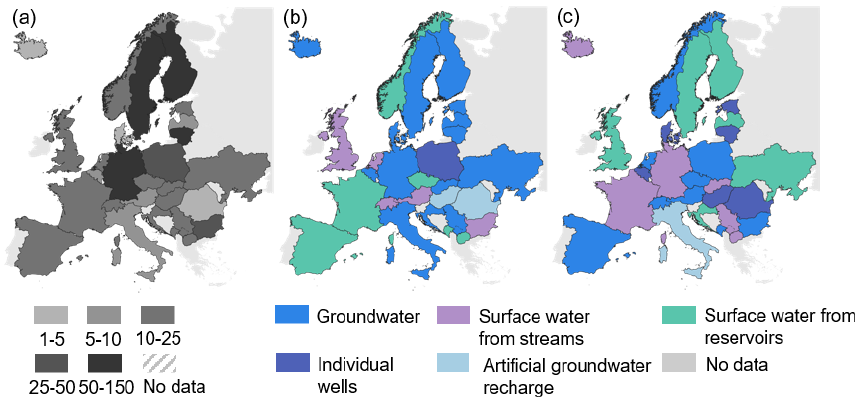
Figure 2. Water usage across Europe: (a) number of survey participants by country, (b) most important water resource by country, and (c) second most important water resource by country. Results are based on a pan-European survey designed by the International Association of Hydrological Science (IAHS) – Panta Rhei “Drought in the Anthropocene” working group and conducted in 28 countries.